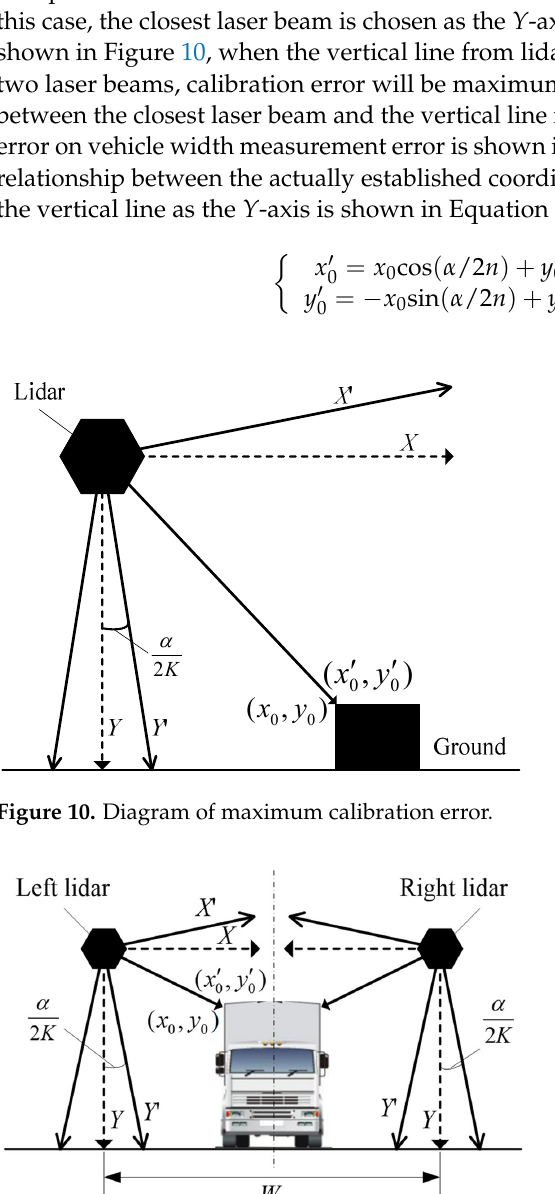
along with the middle of the lane and the horizontal width of the left and right lidars is W 0 , the theoretical vehicle width is calculated according to Equation (15). In consideration of calibration error, the actual measured value is shown in Equation (16). Then, the relative